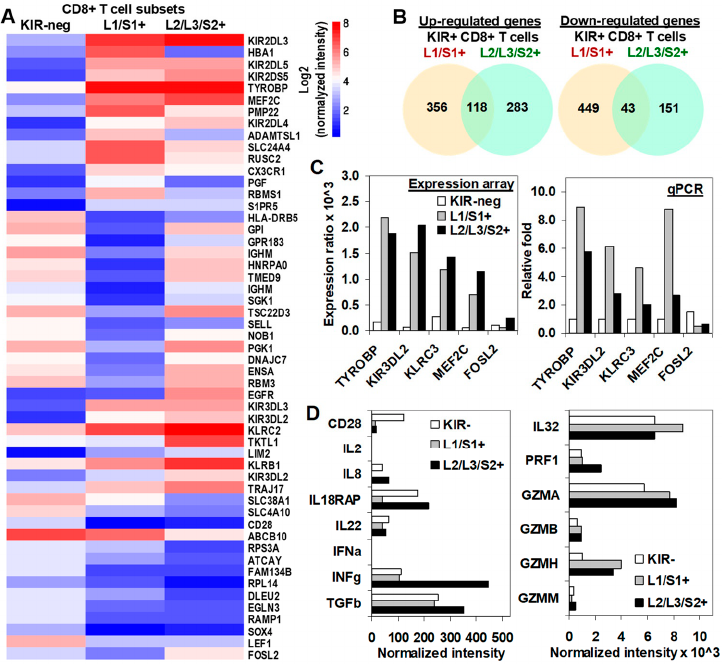
− andKIR2D + CD8 + Tcells. ( A )Di ff Figure 5. Transcriptional profiling of KIR2D − and KIR2D+ CD8+ T cells. ( A ) Differential gene Figure5. TranscriptionalprofilingofKIR2D